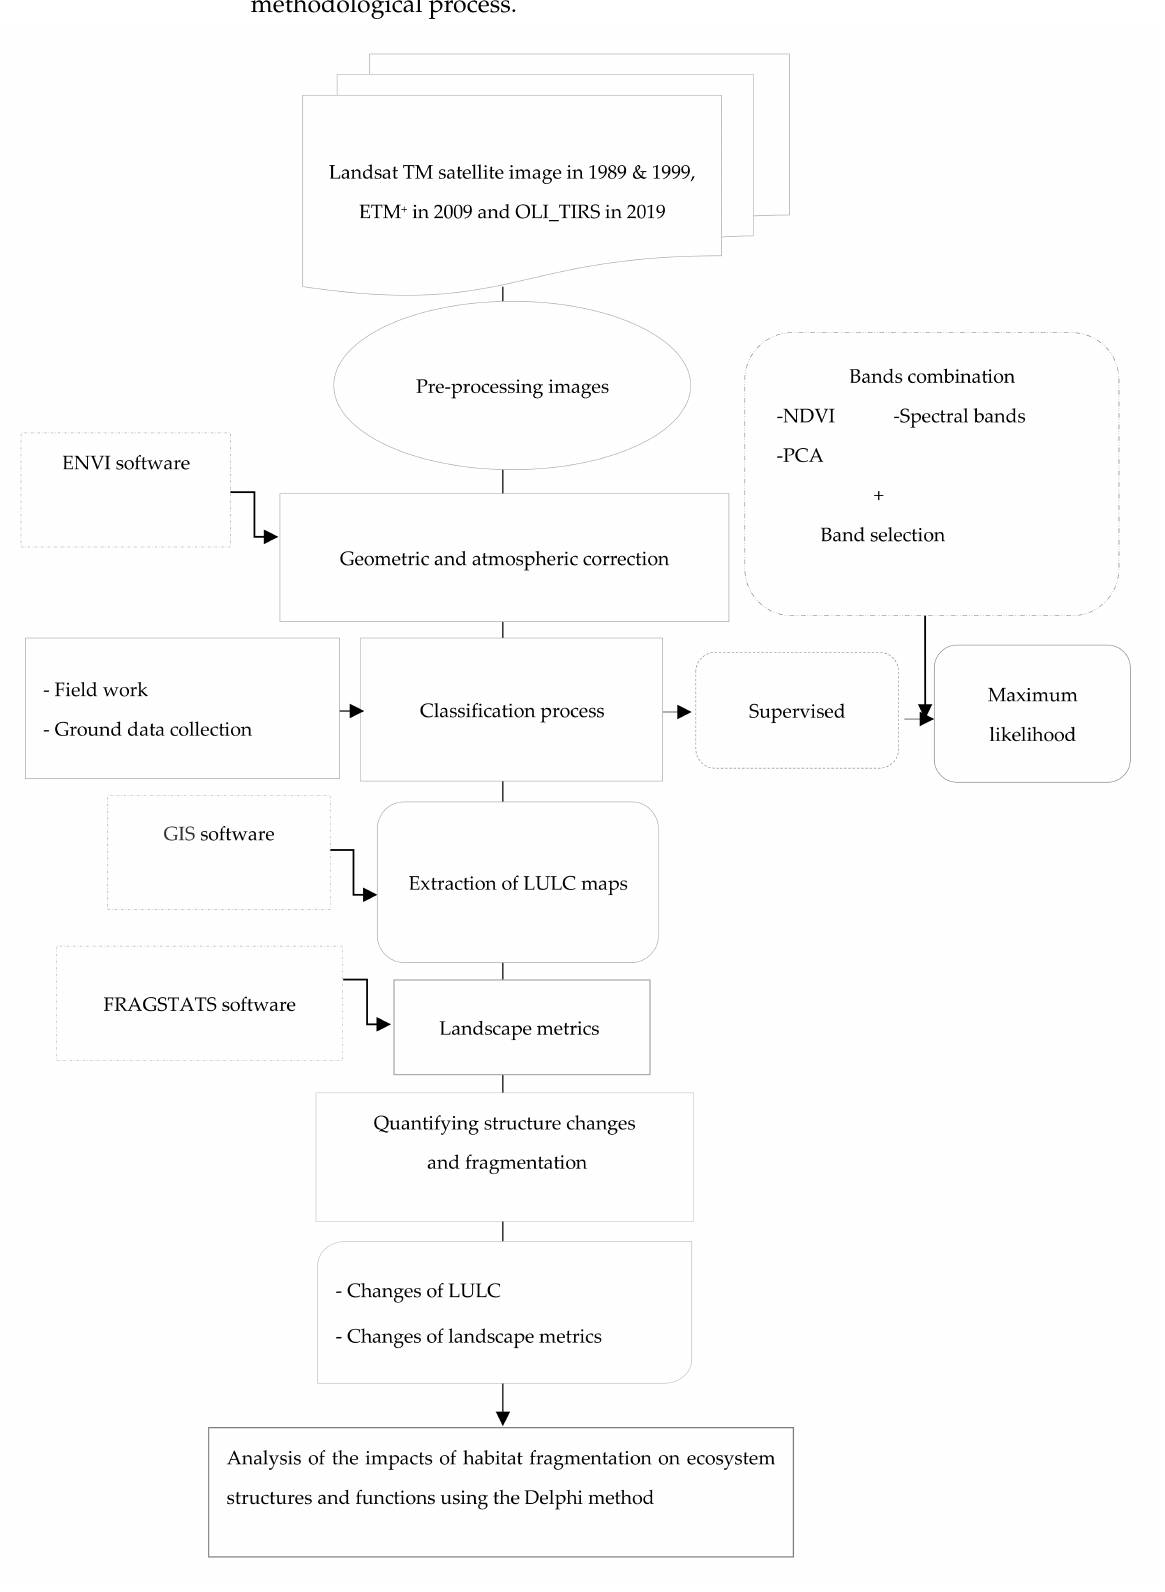
Figure 2. The flow diagram of the